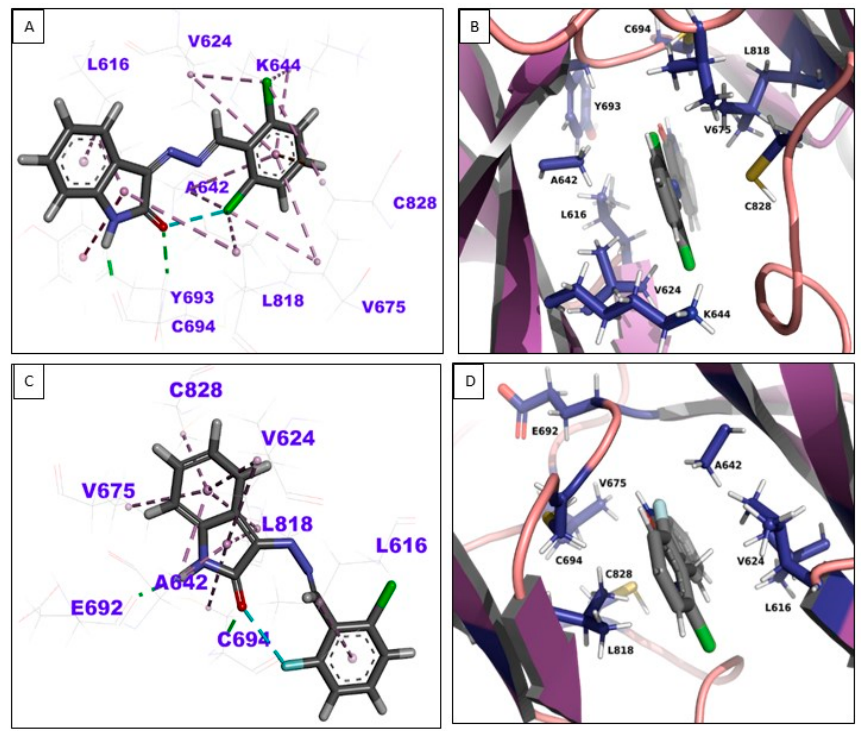
Figure 6. Docking pose of 1 and 2 within the active site of FLT-3 protein kinase: ( A ) 2D of 1 ; ( B ) 3D of 1 ; ( C ) 2D of 2 ; ( D ) 3D of 2 . of 1 ; ( C ) 2D of 2 ; ( D ) 3D of 2